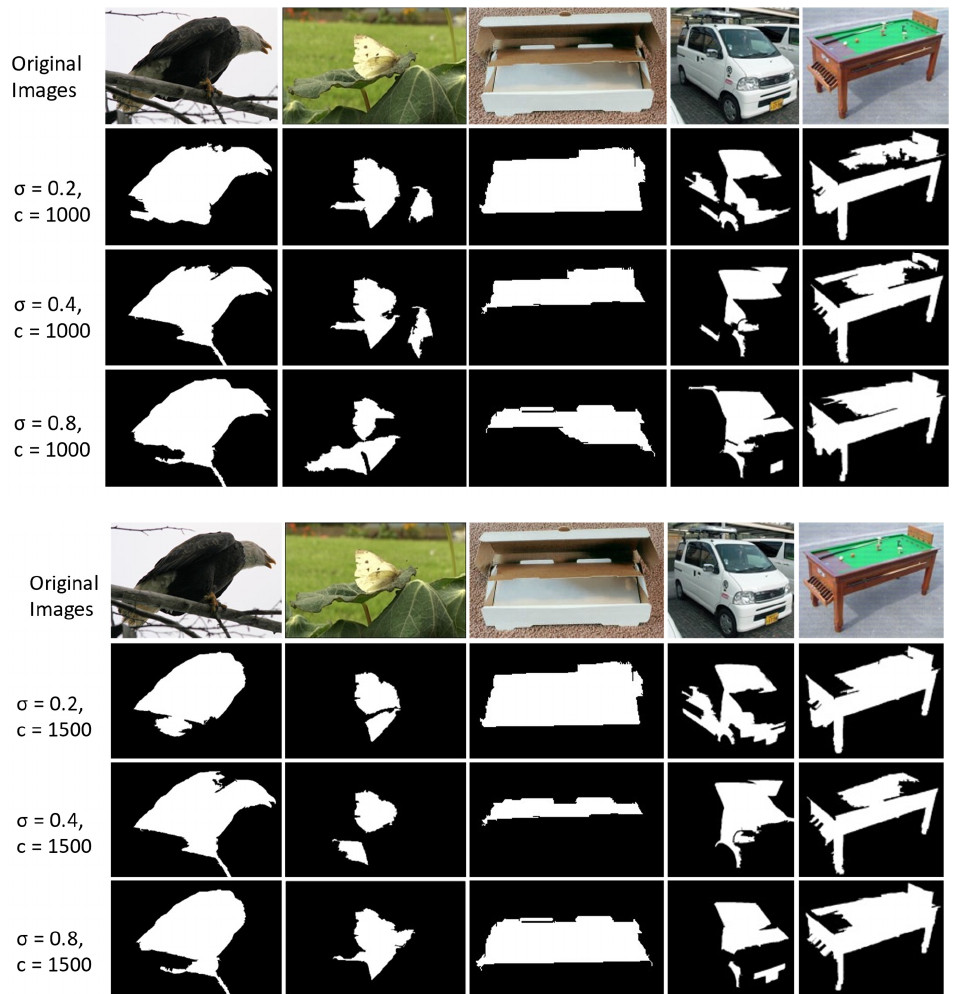
Figure 6. The heuristic binary masks are generated using DRFI with σ = {0.2, 0.4, 0.8} with c = {1000, 1500}.